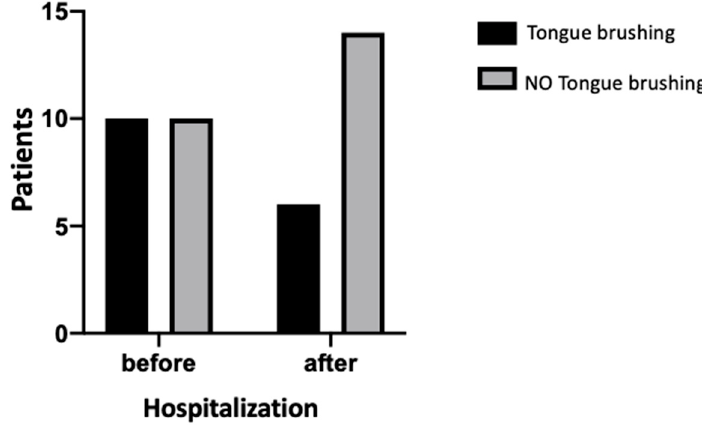
Figure A2. Habit of tongue-brushing before and after hospitalization of the patients. No statistical difference was shown between the study time points ( p = 0.333).